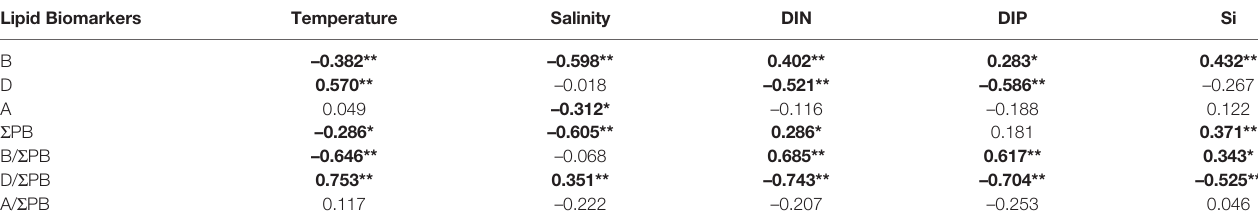
TABLE 1 | Spearman ’ s correlation coef fi cients between lipid biomarkers and temperature, salinity, and nutrients across the surface and DCM layers. Lipid